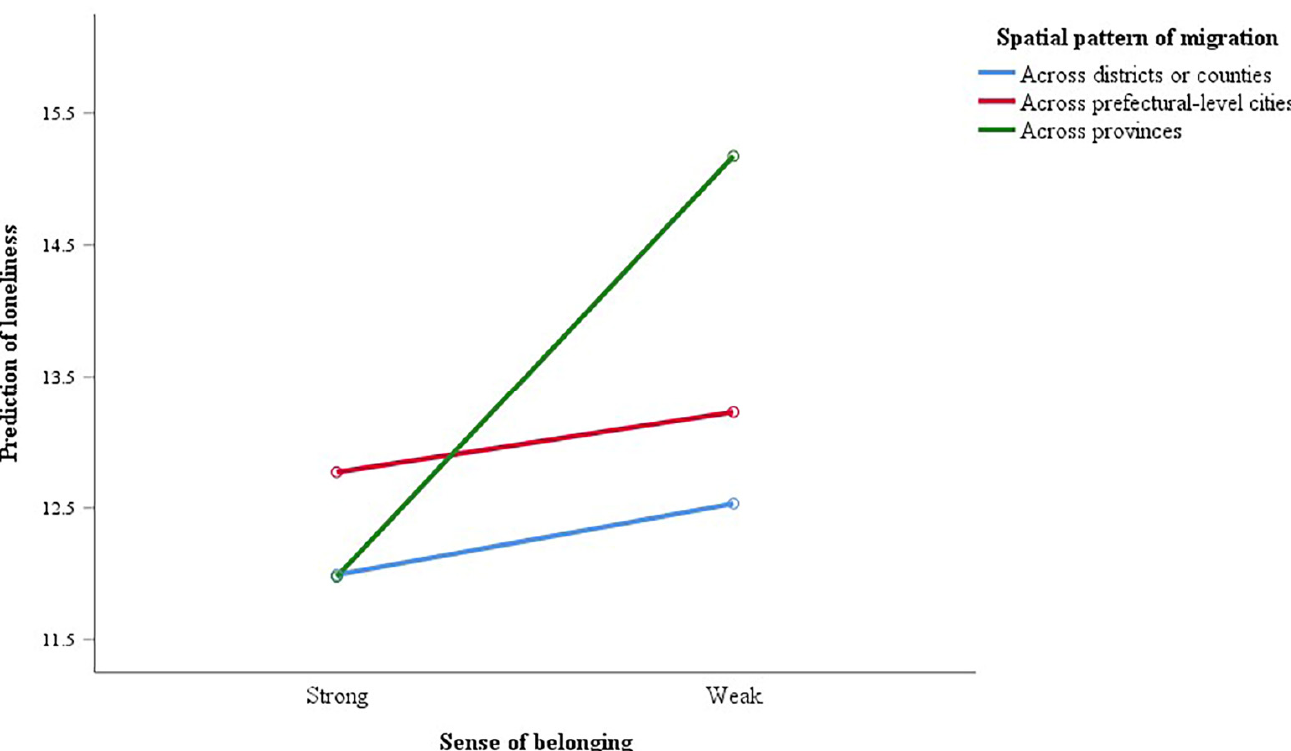
Figure 1. Interaction between sense of belonging and spatial pattern of migration in the prediction of loneliness (adjusted for the covariables in hierarchical multiple regression analysis).